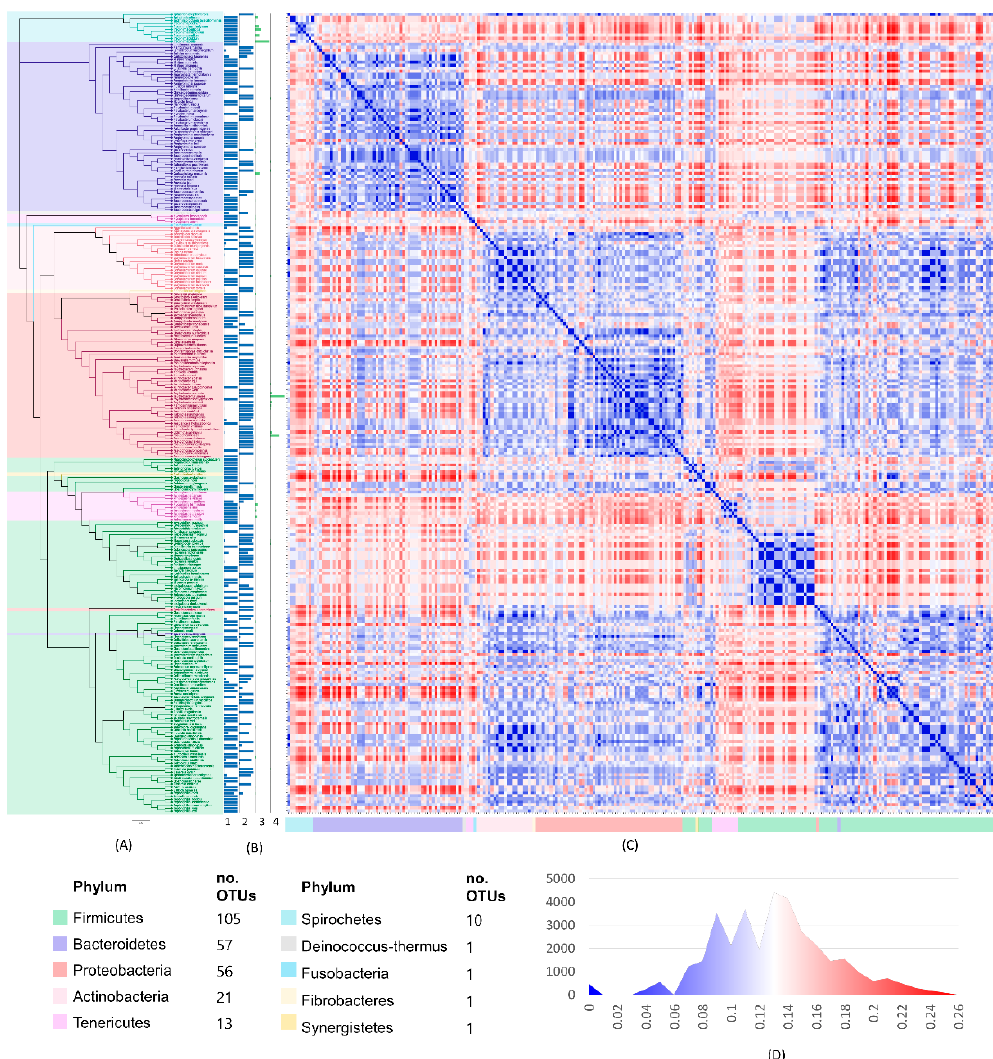
Figure 2. General time-reversible tree representing all observed OTUs in BDD-infected and normal skin samples color-coded based on phylum classification ( A ). The scale value is 2.57. The blue bar graph denotes the abundance ratio of each species on BDD ( B1 ) and normal sample ( B2 ), while the green bar graph shows the actual count per species (OTU) for BDD ( B3 ) and normal ( B4 ) sample. Euclidean distance heat map matrix is based on the nucleotide base substitution rate presenting the divergence between all OTUs in BDD and normal sample ( C ). The graph ( D ) shows the frequency distribution of pairwise comparison between OTUs in each calculated distance from low (blue) to high (red).